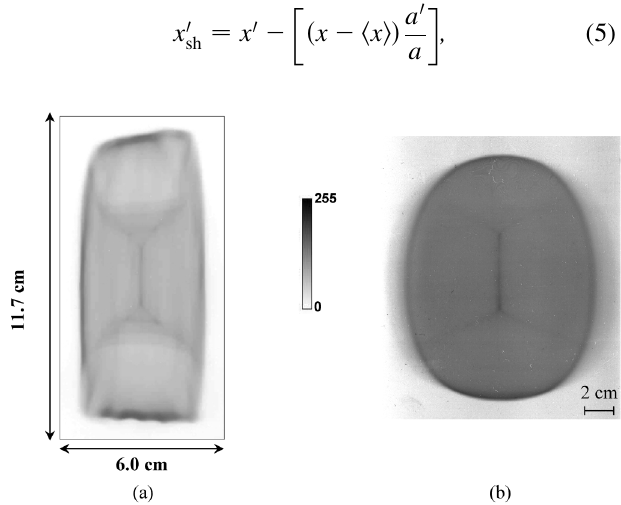
FIG. 9. Kapton film images of the beam at the exit of the injector taken (a) before diode optimization and (b) after diode